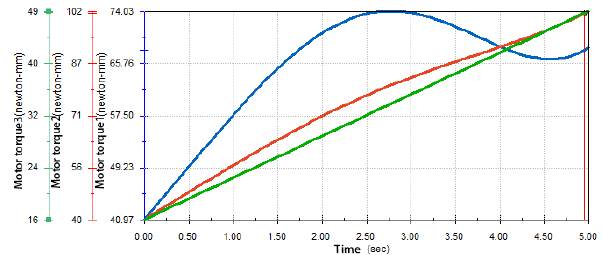
Figure 10. The output curve of motor torque.